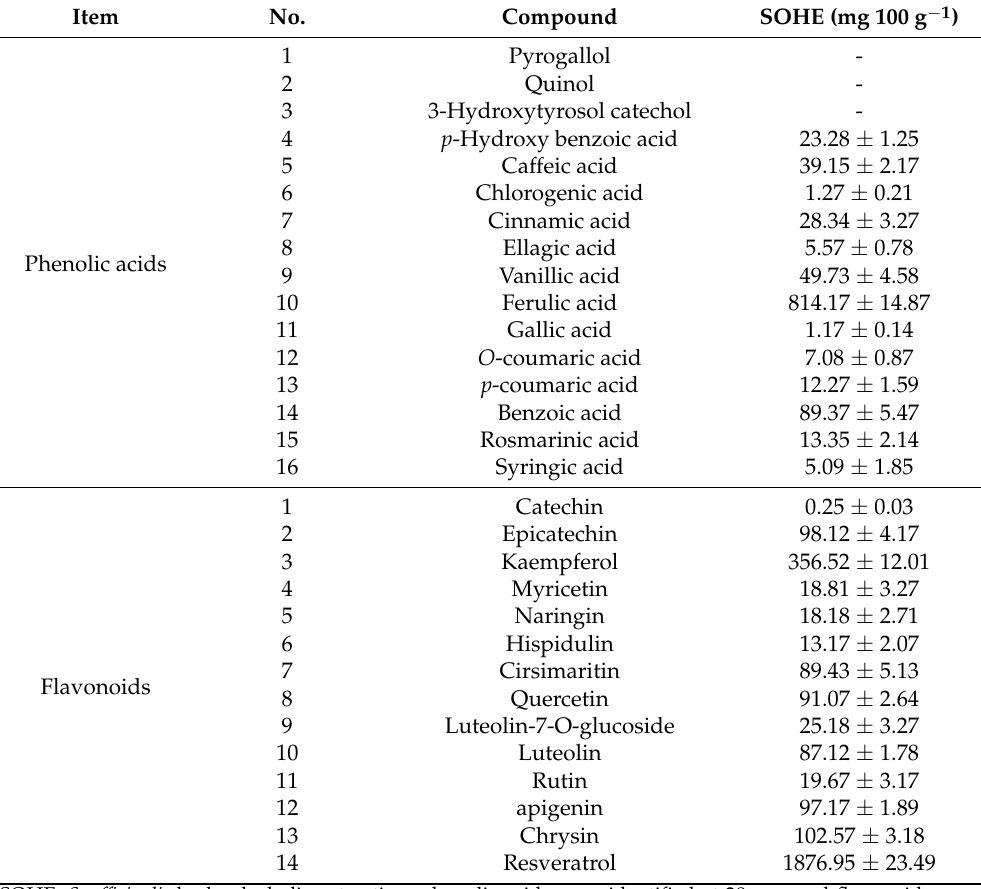
Table 2. Quantitative analysis of phenolic compounds in S. officinalis leaves (mean ± SE), n = 3. Item